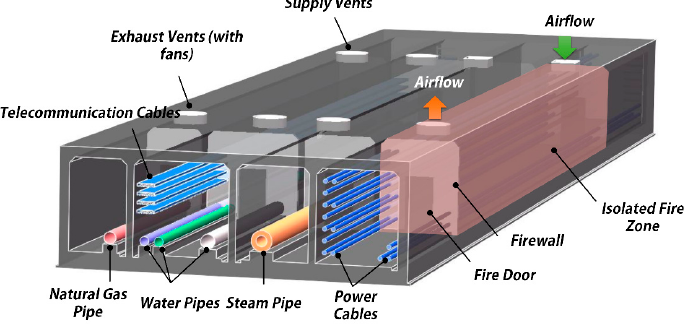
Figure 1. A common utility tunnel.